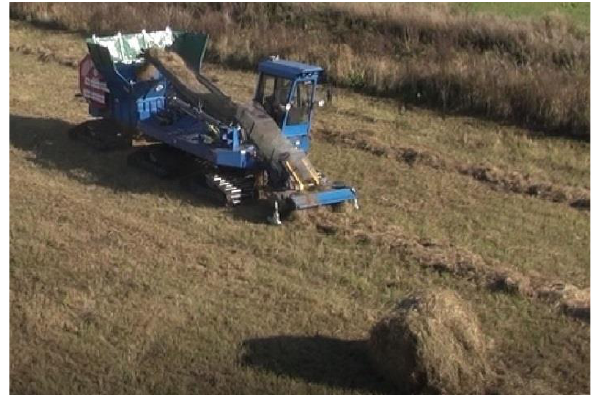
Figure 3. The tracked vehicle units designed by PIMR for non-stop swath collecting and forming bales. Photo: PIMR archive.